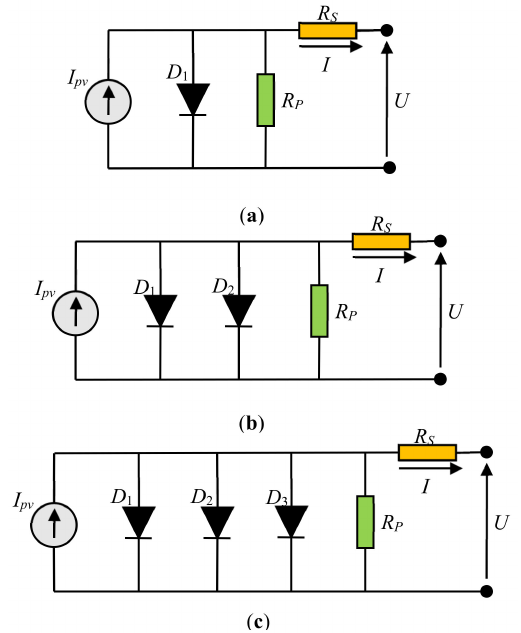
Figure 1. Common diode models of solar PV equivalent circuits: ( a ) SDM, ( b ) DDM, and ( c ) TDM. The current ( I )–voltage ( U ) relationship of these models can be described for